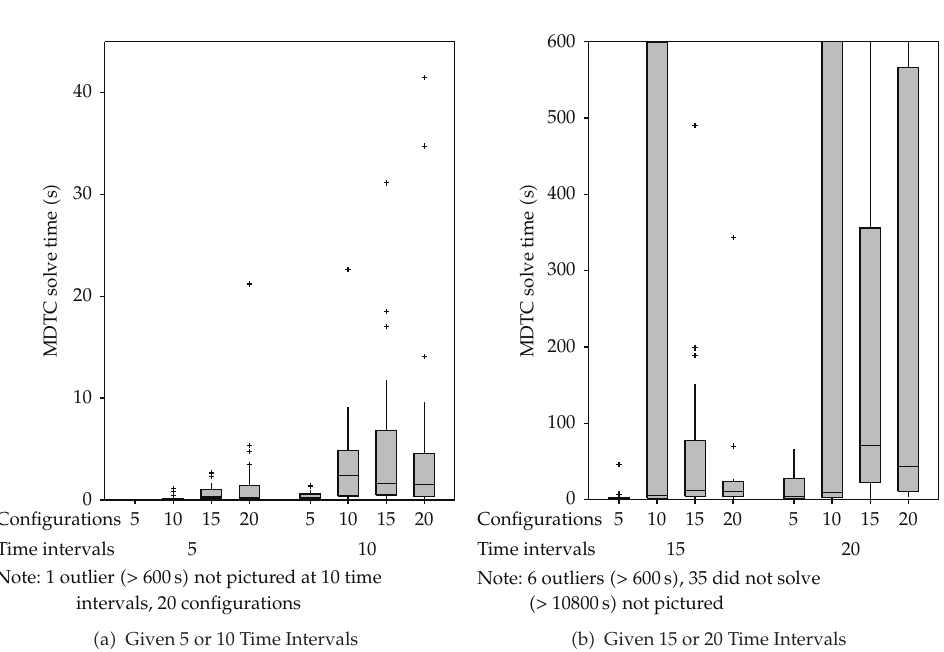
Figure 13: MDTC solve times (cid:2) Determined using AMPL’s timing parameter total solve time, a measure of system and user CPU seconds used by all solve commands. (cid:3) under various problem